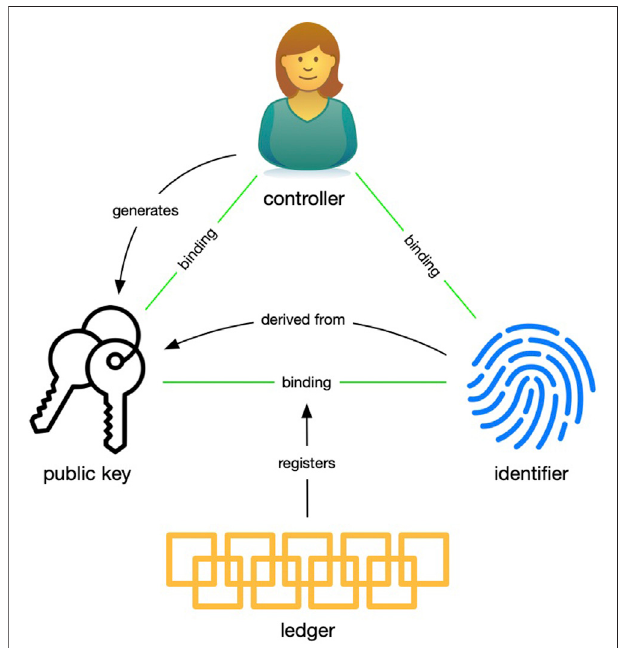
FIGURE 3 | The trust basis in algorithmic identity